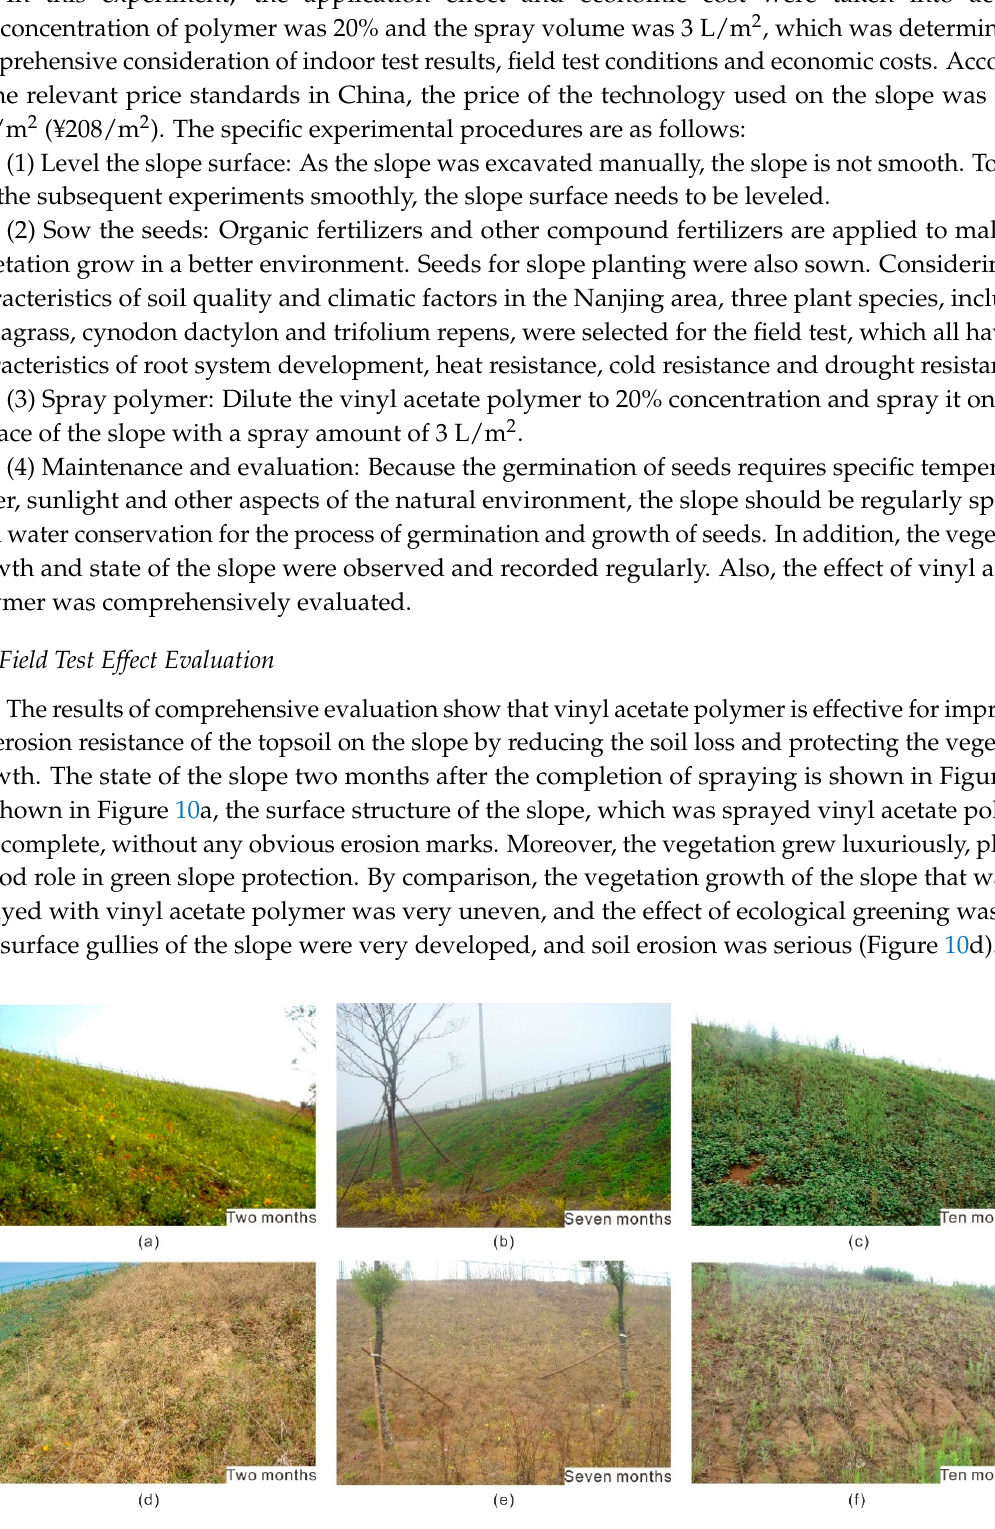
Figure 10. The state of the slope: ( a – c ) with polymer; ( d – f ) without polymer.